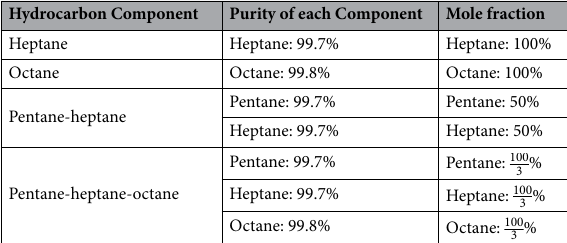
Table 3. Purity and mole fraction of the alkanes used in the experiments.